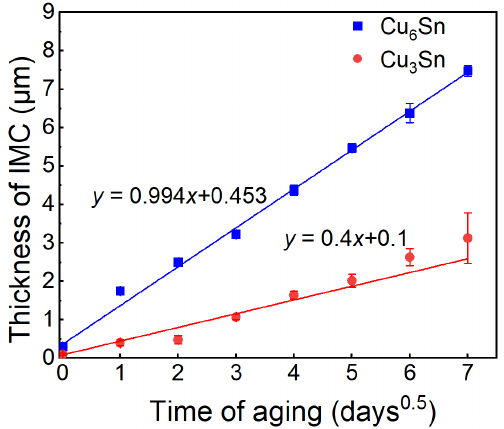
Figure 9. Curve fitting of IMC growth at solder–pad interface.